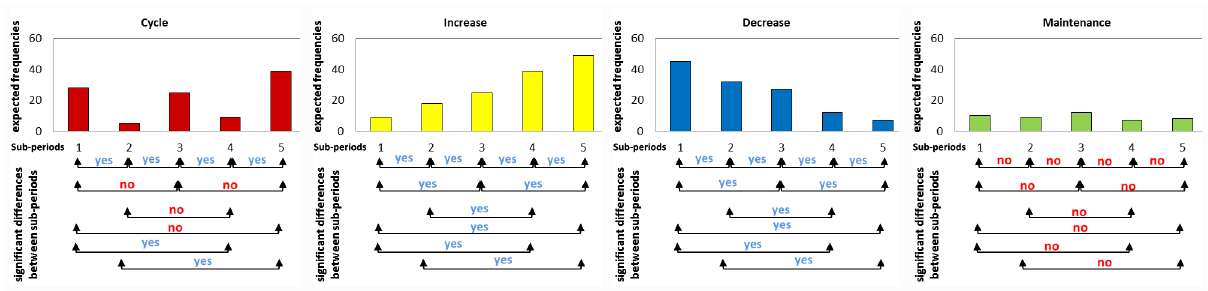
Fig. 4. Pattern charts and results for the Scheff´e multiple comparison method in the presence of a cyclic, upward trend, downward trend and maintenance behaviour. Arrows point to pairs of sub-periods being compared: “yes” when their differences are significant, “no” otherwise. In the case of trends: if the expected frequencies are increasing, the trend sign is positive; if the expected frequencies are decreasing, the trend sign is